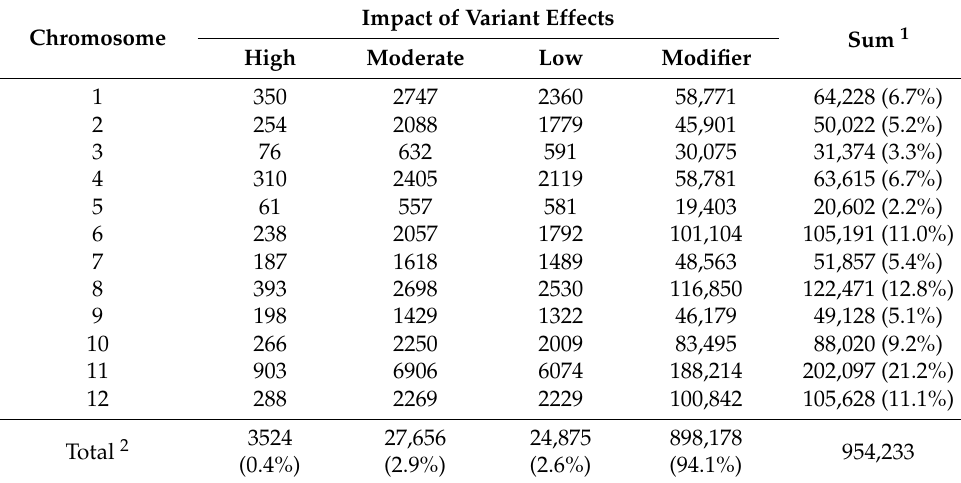
Table 2. Classification of variants by predicted effects on gene function.